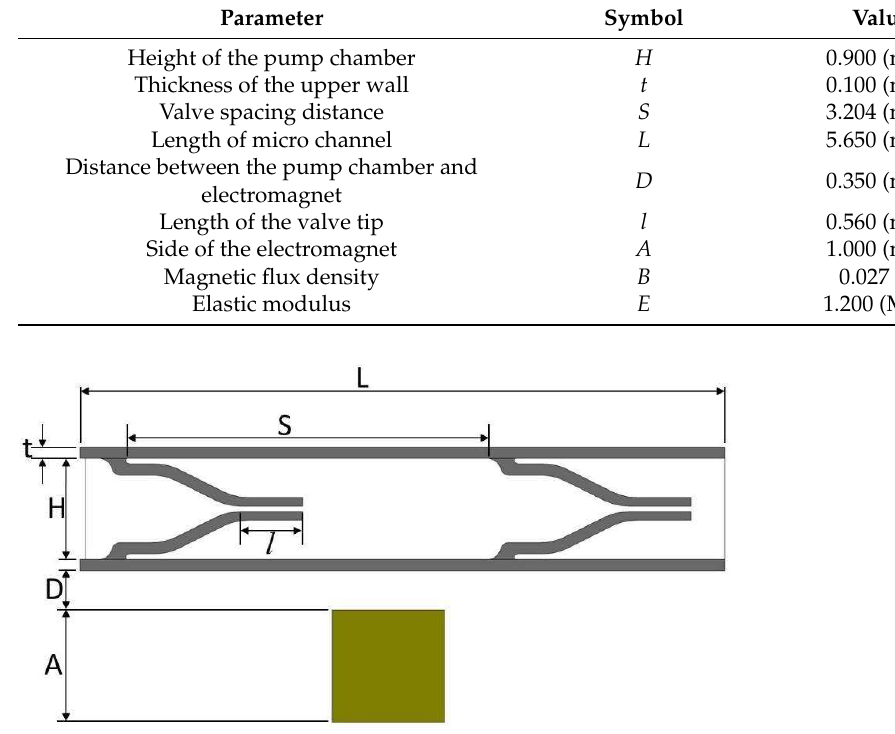
Table 1. Properties of duckbill valve model.